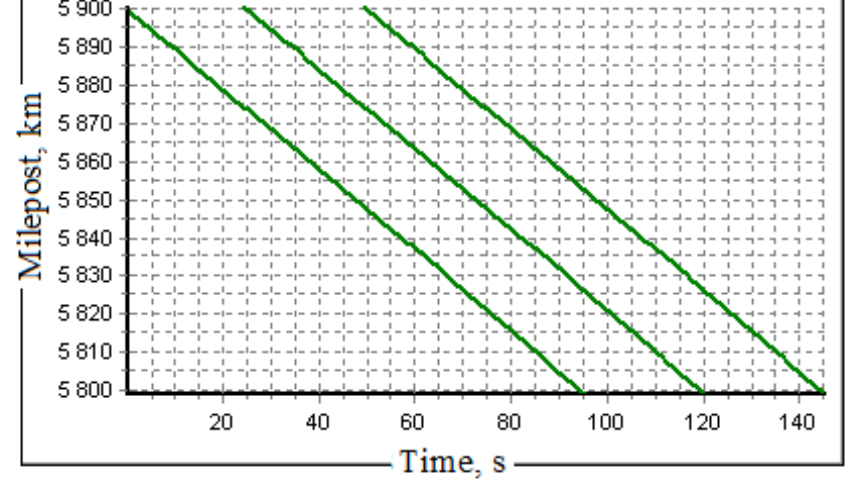
Figure 14. Train schedule.